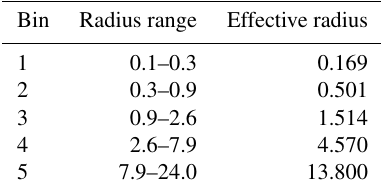
Table 1. Size ranges and effective radii of the five COSMO- MUSCAT size bins (µm). Mineral densities are assumed to